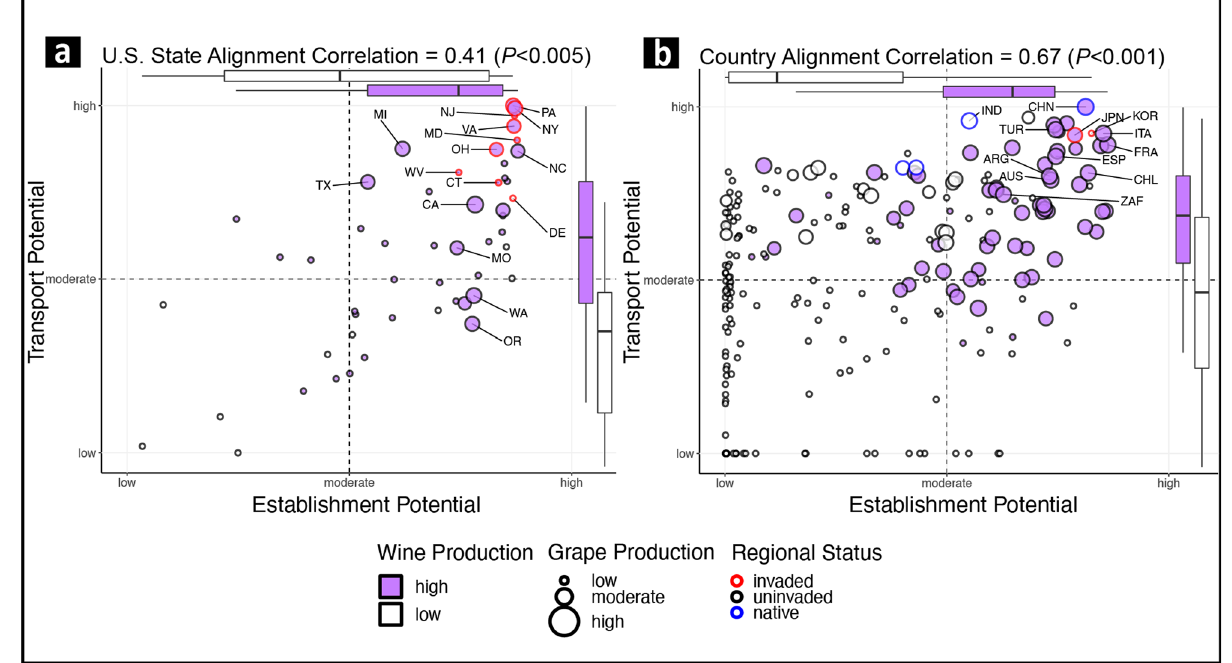
Fig. 5 Spotted lantern fl y ( Lycorma delicatula ) invasion potentials are aligned for wine and grape-producing regions. States ( a ) and countries ( b ) that produce most of the global supply of grapes (point size) and wine (point fi ll color) also have high transport and establishment potentials. Invaded regions and the top-10 grape-producing regions are labeled; box plots split the distributions of establishment potential and transport potential into high (purple) and low (white) wine-producing regions (center line is the median, box limits are the upper and lower quartiles, and whiskers are 1.5 × the interquartile range); dashed lines divide the data into high-high, high-low, and low-low potential quadrants; and axes are scaled and formatted as suggested by the pandemic severity assessment framework 8,9 . Point color indicates high and low wine-producing regions. Point size depicts grape production in metric